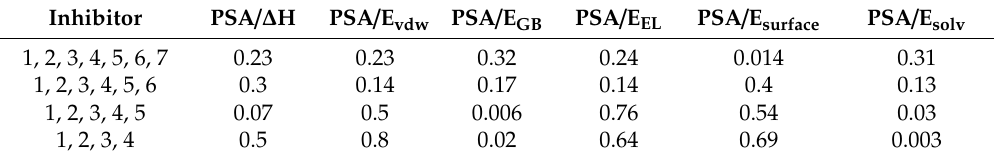
Table 6. Correlation coeffecients of polar surface area with each energy contribution for various inhibitors.